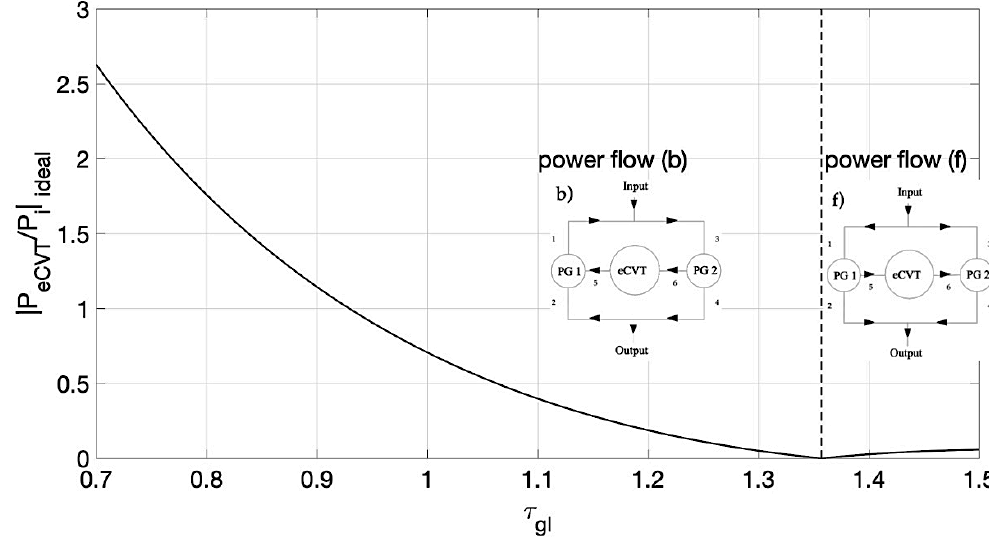
Figure 6. eCVT power fraction vs. global transmission ratio, given the input design parameters of Equations (28) and (29).